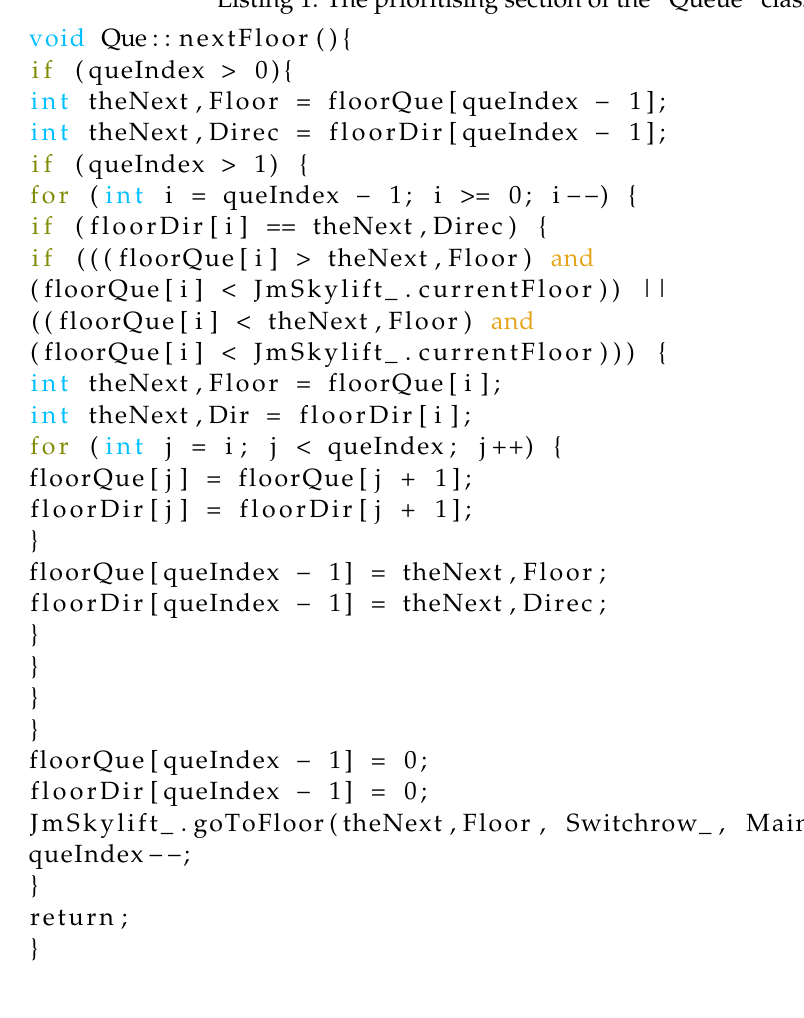
Listing 1: The prioritising section of the “Queue”